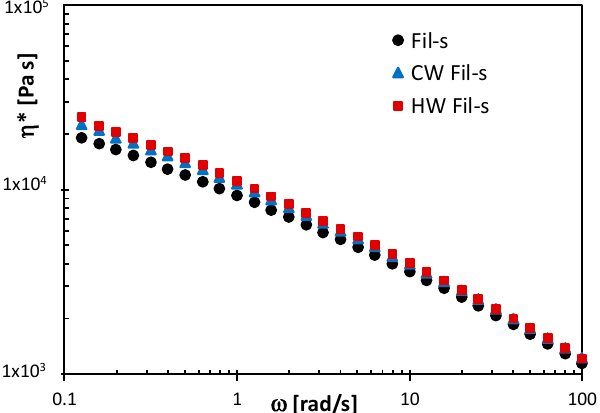
Figure 2. Comparison between the complex viscosity plots of the unwashed, Cold Washed and Hot Washed Fil-s samples.